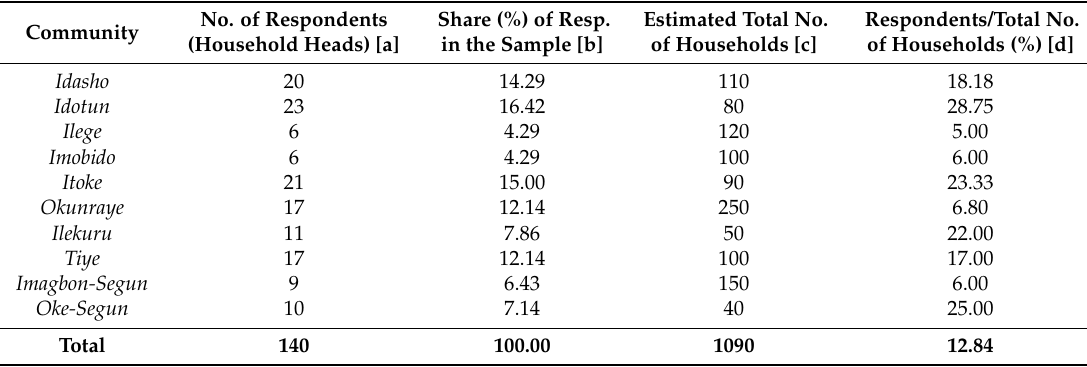
Table 4. Sample composition: respondents by community.